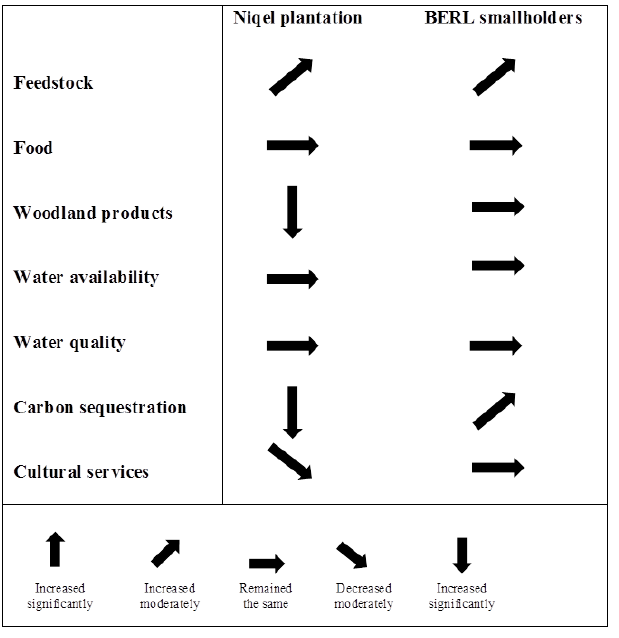
Fig. 6 . Changes in the provision of ecosystem services after land transformation in Niqel and BERL